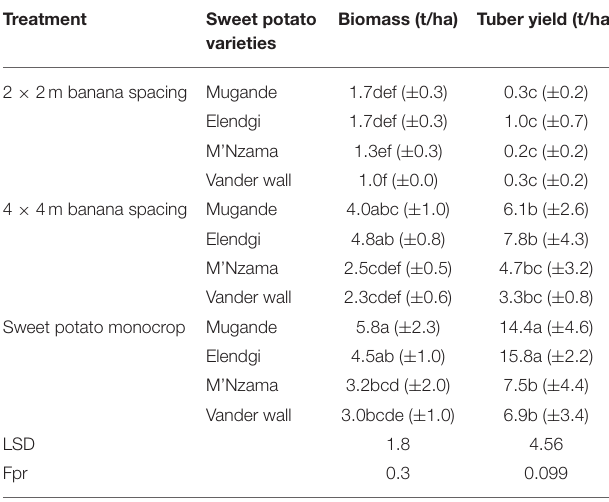
TABLE 6 | Aboveground biomass yield for various sweet potato varieties at INERA-Mulungu. Treatment Sweet potato